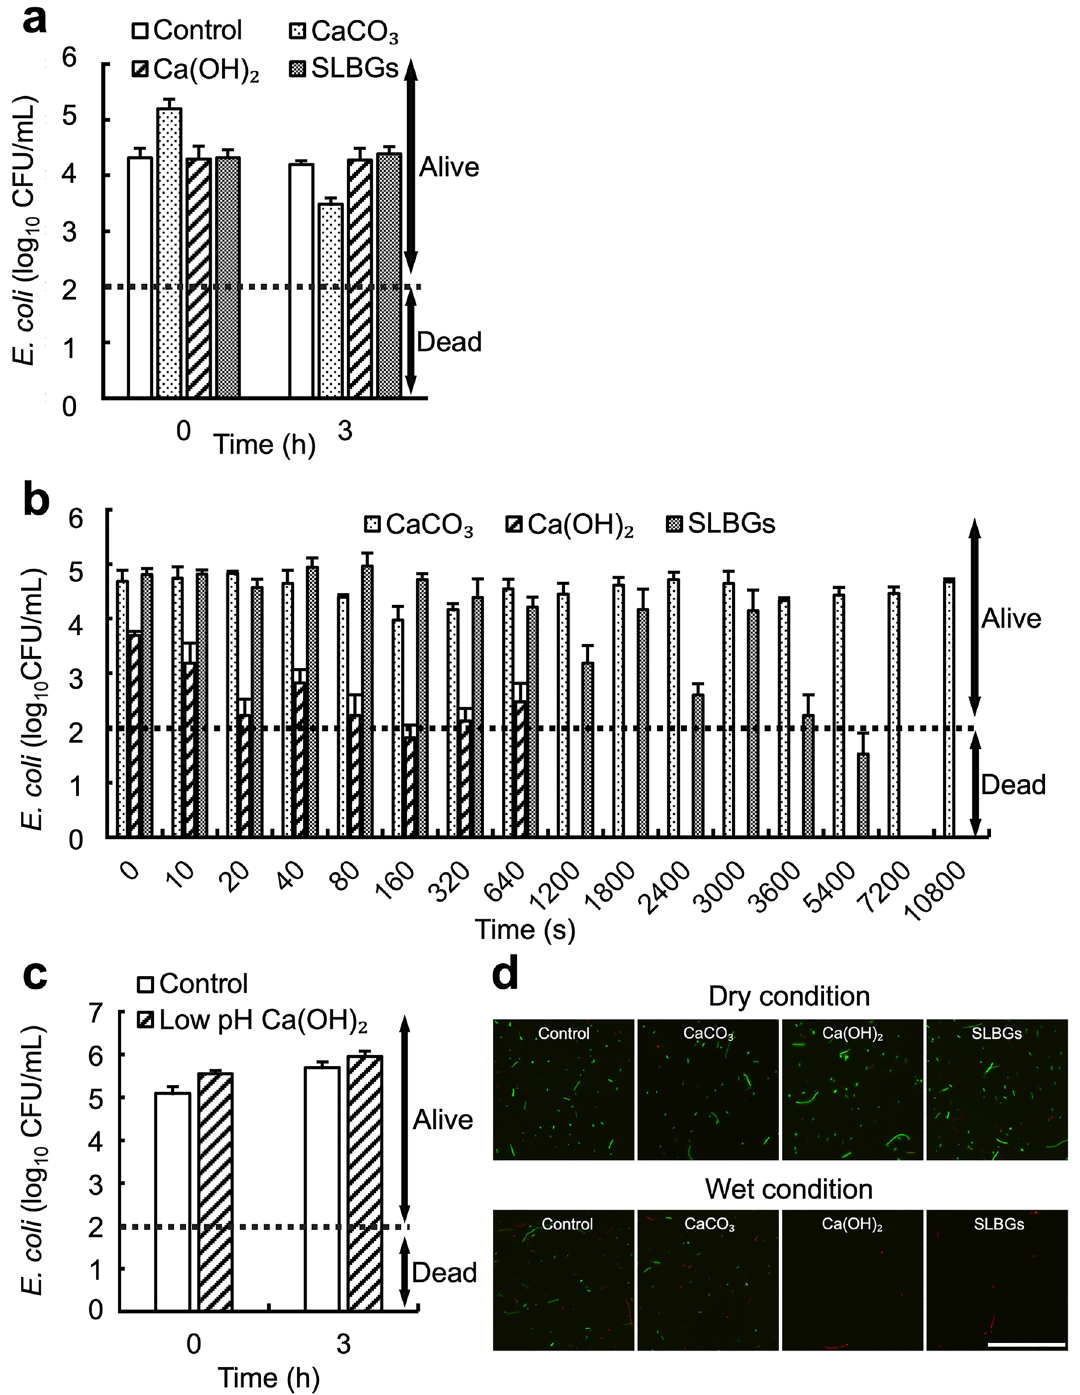
Figure 3. The effect of water on disinfection. ( a ) E. coli abundance (log 10 colony-forming units, CFU) after contact without (control) or with disinfectant (CaCO 3 , CA(OH) 2 , or SLBGs) with no water added (dry condition) for 3 h. The dashed line indicates the detection limit estimated from the dilution ratio. ( b ) E. coli abundance after contact with disinfectant (CaCO 3 , Ca(OH) 2 , or SLBGs) with water added (wet condition) for up to 3 h. ( c ) E. coli abundance after contact without (control) with low pH Ca(OH) 2 (in this Ca(OH) 2 , pH was reduced to about 9.28 in the door test for 63 days in Fig. 2d) with water added (wet condition) for up to 3 h. ( d ) Live/dead assay with disinfectant (control, CaCO 3 , Ca(OH) 2 , or SLBGs) in dry and wet conditions after 3 h. Images were captured using a fluorescence microscope equipped with a 20 × objective. Bar, 100 μm. Data in a , b , and c represent the mean and SD (error bars) from three separate experiments. Alive and Dead in a , b , and c indicate the range of CFU in which the number of colonies was observed and the range of CFU below the detection limit (2 log 10 CFU/mL) in which no colonies were observed,